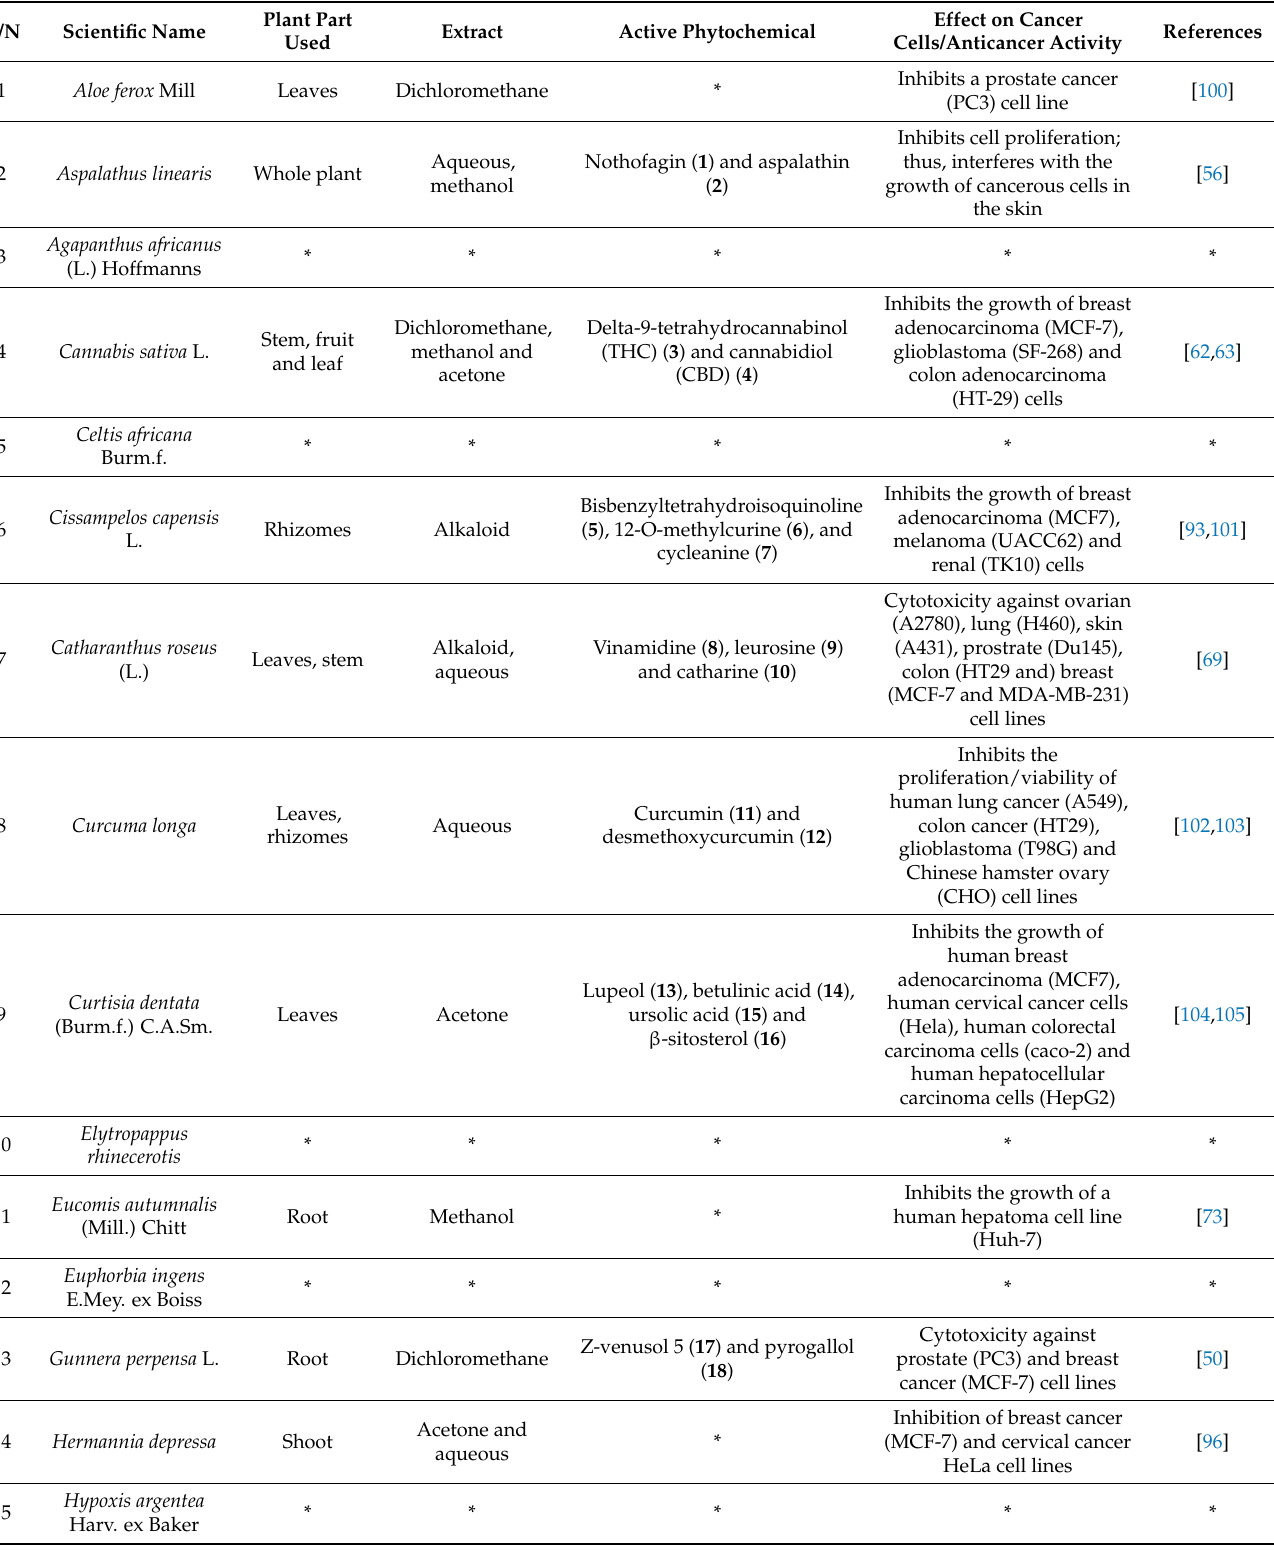
Table 3. Reported anticancer activity of medicinal plants used in the Eastern Cape province, South